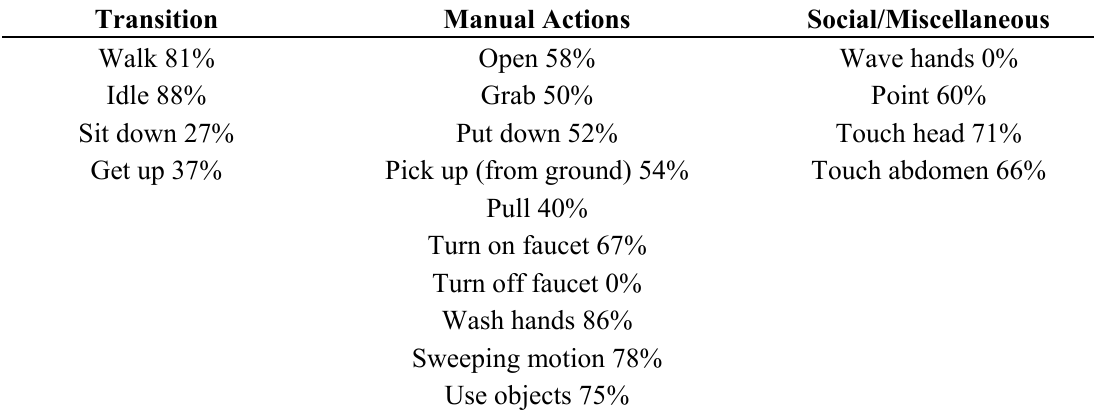
Table 1. Actions classified by the pattern recognition system and their classification accuracy as